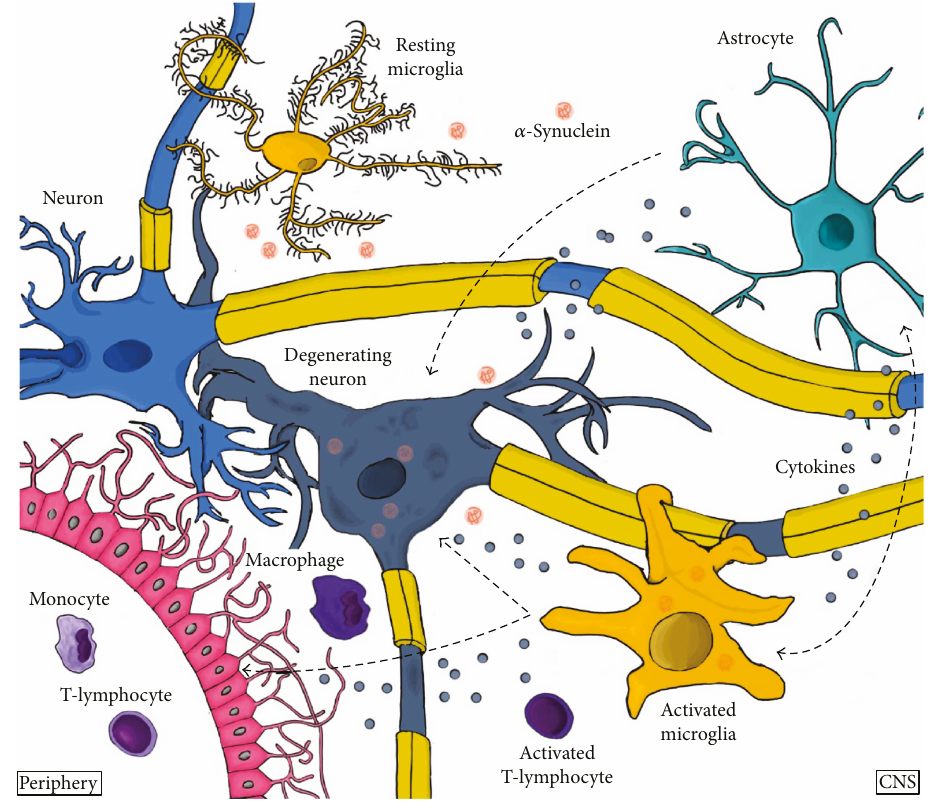
Figure 2: Possible link between α -synuclein, neuroin fl ammatory processes, and neurodegeneration in Parkinson ’ s disease. In the presence of speci fi c α -synuclein conformations, microglia get activated and induce a complex immune response by increasing the expression of toll-like receptors and several proin fl ammatory mediators, which consequently activates peripheral immune cells like monocytes or T cells. These peripheral immune cells might actively contribute to